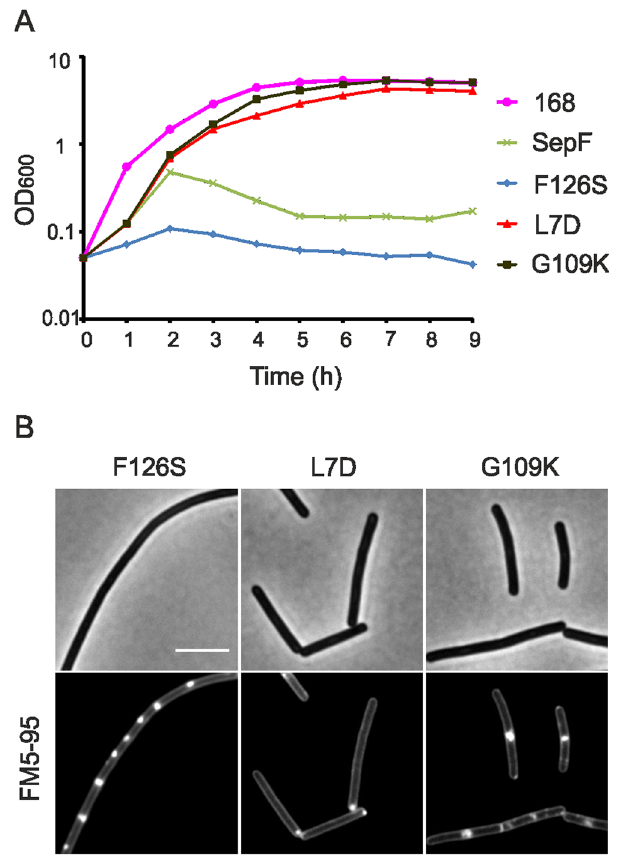
Figure 8. Importance of FtsZ interaction, membrane binding and multimerization domains of SepF. ( A ) Growth of ∆ sepF strains containing ectopic copies of SepF mutants F126S, L7D or G109K, which either impair FtsZ binding, membrane binding or multimerization, respectively (strain GYQ215 amyE:: P xyl-sepF , strain GYQ207 amyE:: P xyl-sepF-F126S ∆ sepF, strain GYQ205 amyE:: P xyl-sepF-L7D ∆ sepF , strain GYQ206 amyE:: P xyl-sepF-G109K ∆ sepF ). Cells were grown in medium supplemented with 1% xylose to induce the SepF mutants. ( B ) Microscopic images of strains GYQ205, GYQ206 and GYQ207 after 3 h growth in the presence of xylose. Membrane invaginations are most apparent when SepF-F126S is expressed. Cells were stained with membrane dye FM5-95. Scale bar is 5 µ